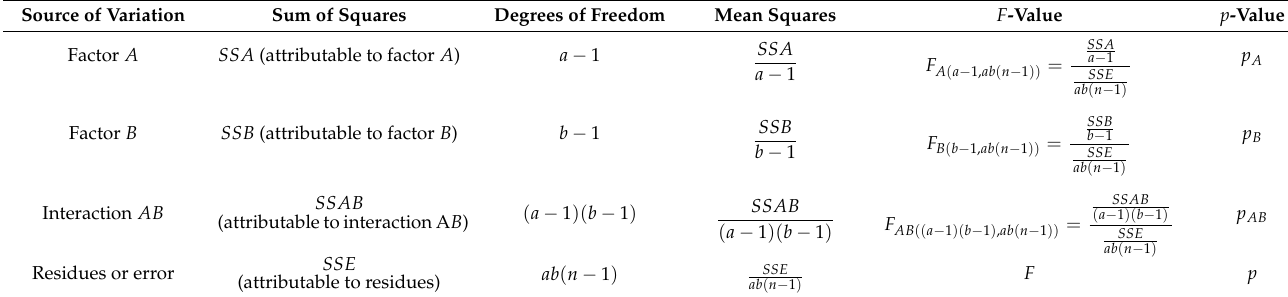
Table 3. Key elements of two-way ANOVA